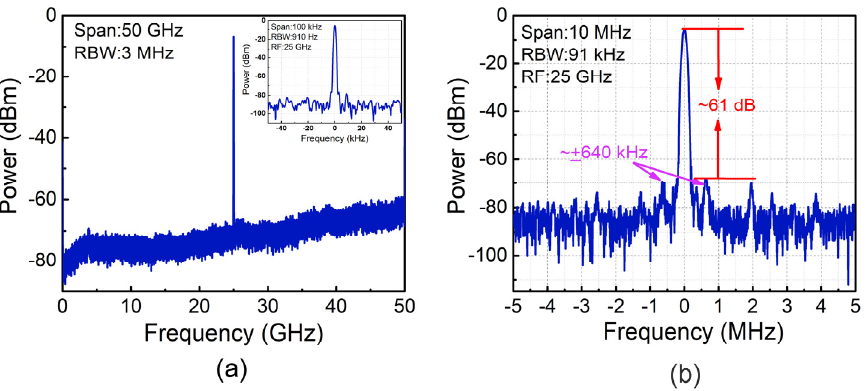
Figure 3. The 25 − gigahertz regenerative mode-locked laser with 320 − m single-mode fiber ( a ) RF power spectrum in a 50 − gigahertz and 100 − kilohertz (inset) span; ( b ) RF power spectrum in a 10 − MHz span.